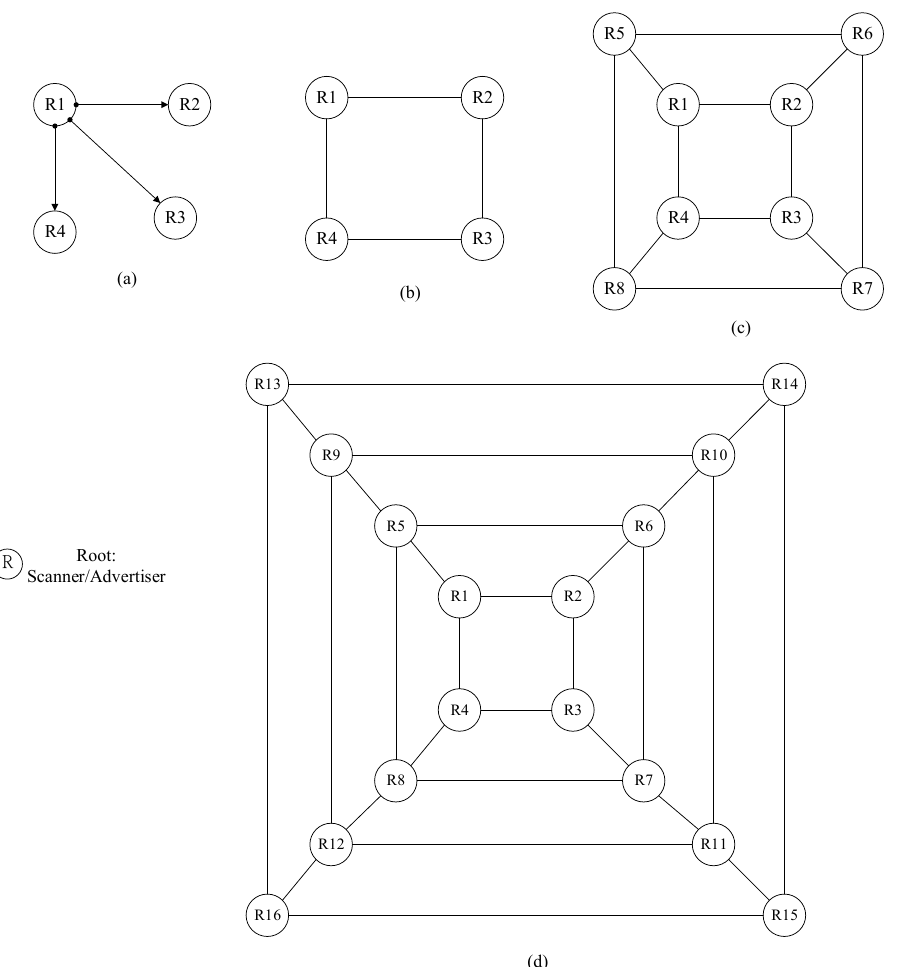
Figure 2. Formation example of an optimal multi-ring subnet: ( a ) R1 propagates the connection information for R2, R3 and R4; ( b ) The first-tier ring is formed by connecting R1, R2, R3 and R4; ( c ) Each first-tier root connects with its downstream root to form the second-tier ring; ( d ) The 4 by 4 multi-ring is generated until the outermost 4-ring is reached.